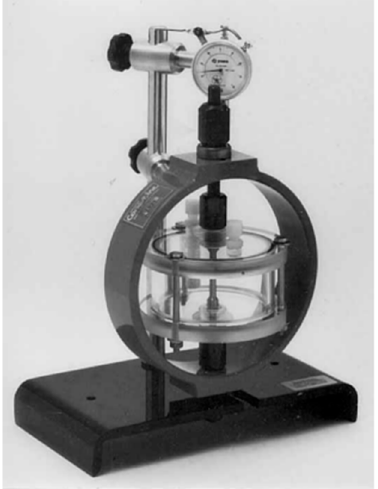
Figure 4. Proof ring .